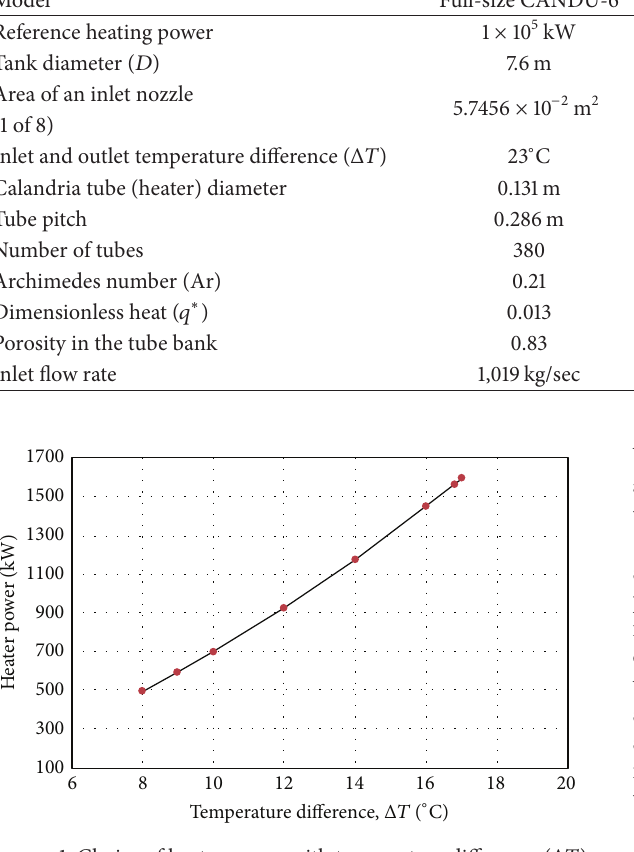
Figure 1: Choice of heater power with temperature difference ( Δ𝑇 ) for 1/4 scale